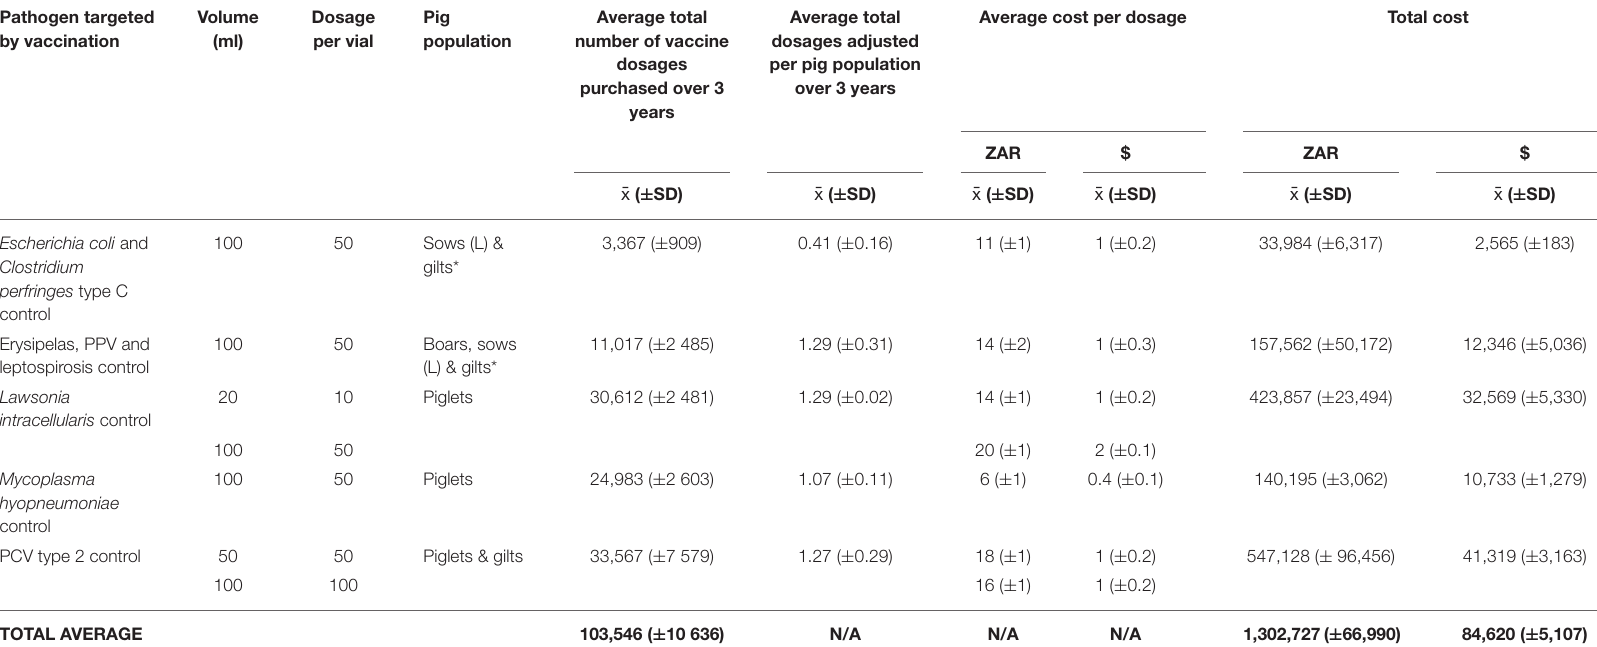
TABLE 4 | Average vaccine usage and expenditure in a commercial pig farm in South Africa over a three-year period